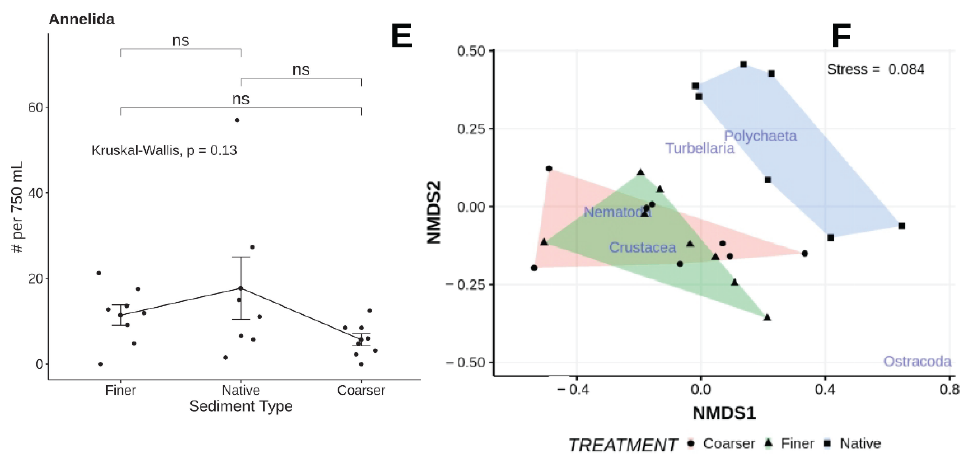
Figure 14. Mean ( ± 1 SE) and observed abundances (dots) for major taxa ( A – E ) observed in the different treatments of the sediment selection experiment. Horizontal lines and associated probabilities (above each line) indicate results of separate Kruskal–Wallis comparisons of respective means. nMDS ordination of species assemblages associated with each experimental sediment type shown in ( F ); non-metric scales serve to ease visual estimation of dissimilarity distances but are not associated with any specific units. ns — p > 0.05, *— p < 0.05, **— p < 0.01, ***— p < 0.001.